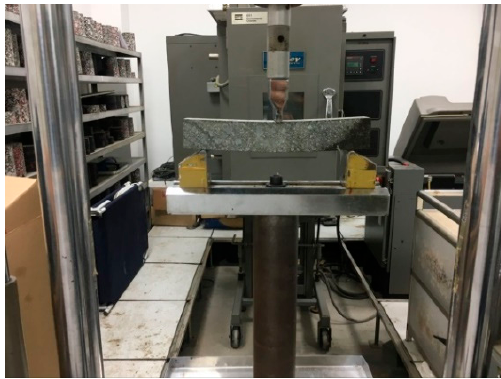
Figure 9. Impact touchness test.